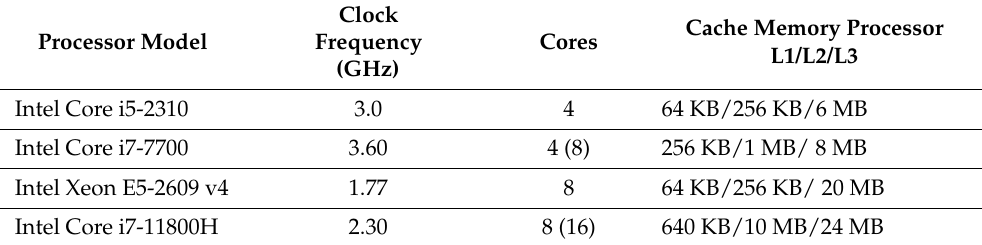
Table 1. Characteristics of Intel